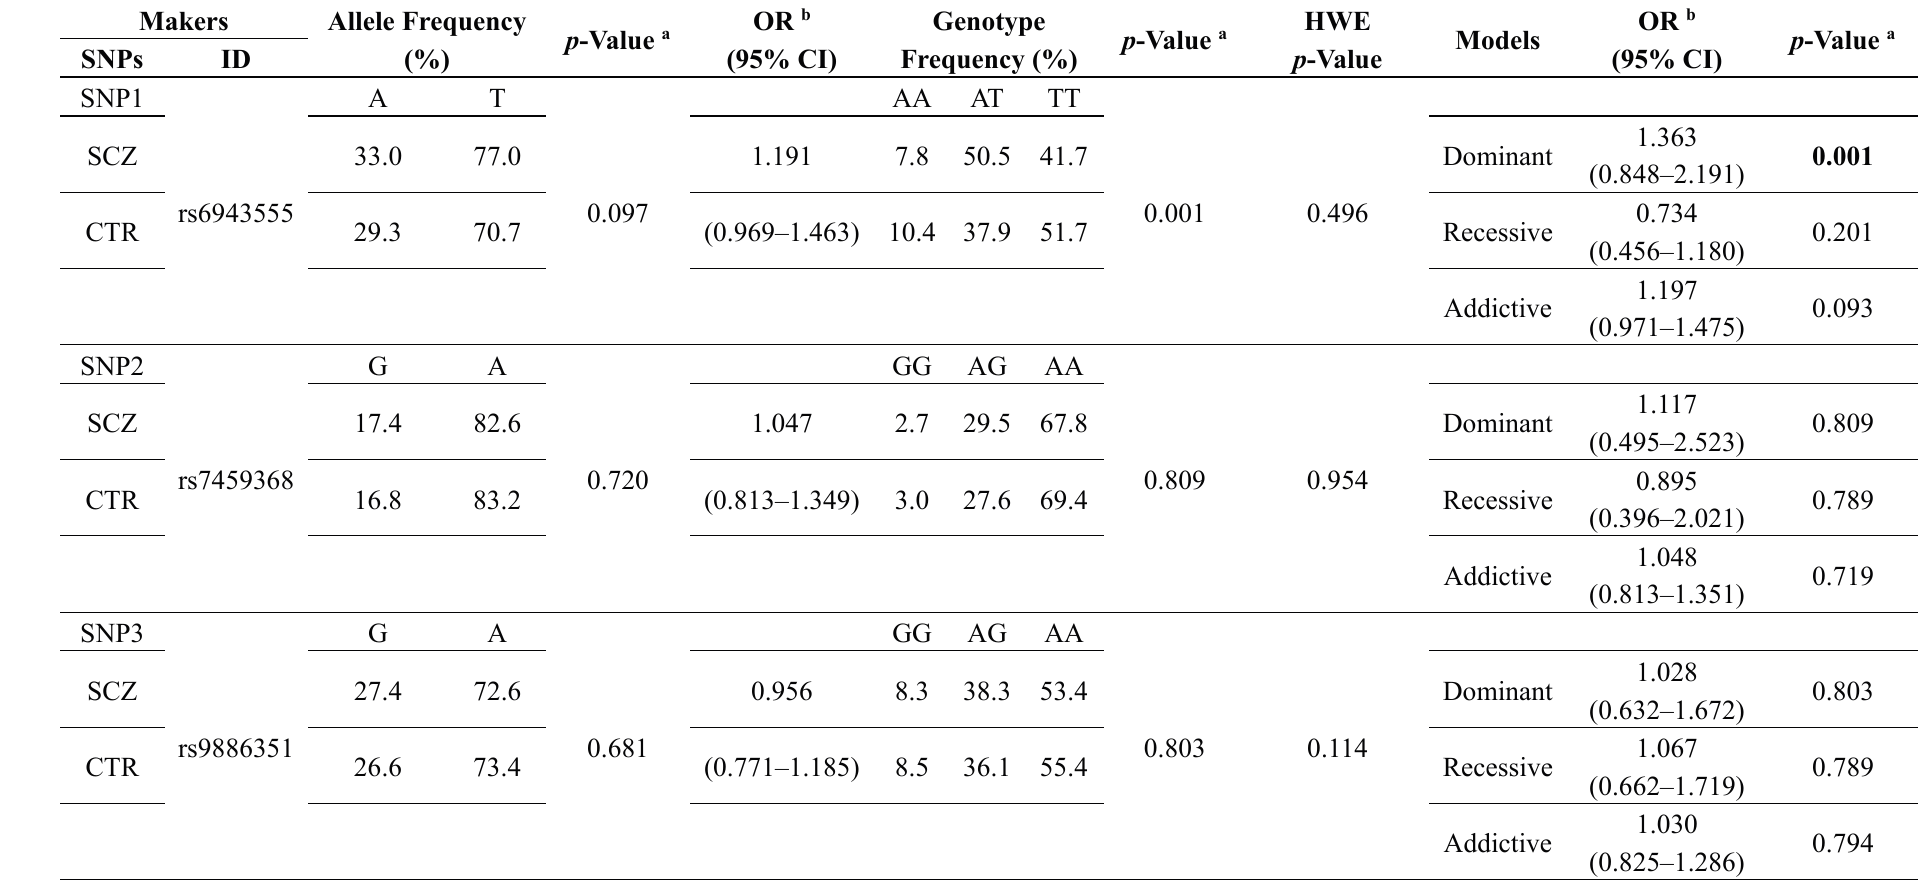
Table 1. Allelic and genotypic frequencies of the single-nucleotide polymorphism (SNP) association